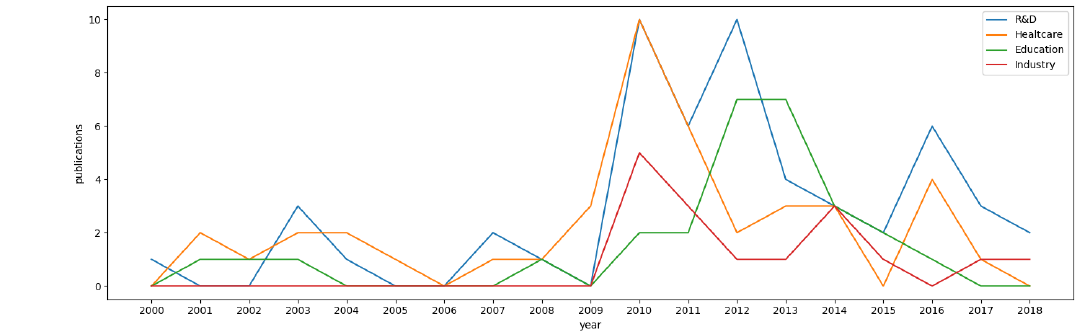
Figure 9. Evolution of publications of all